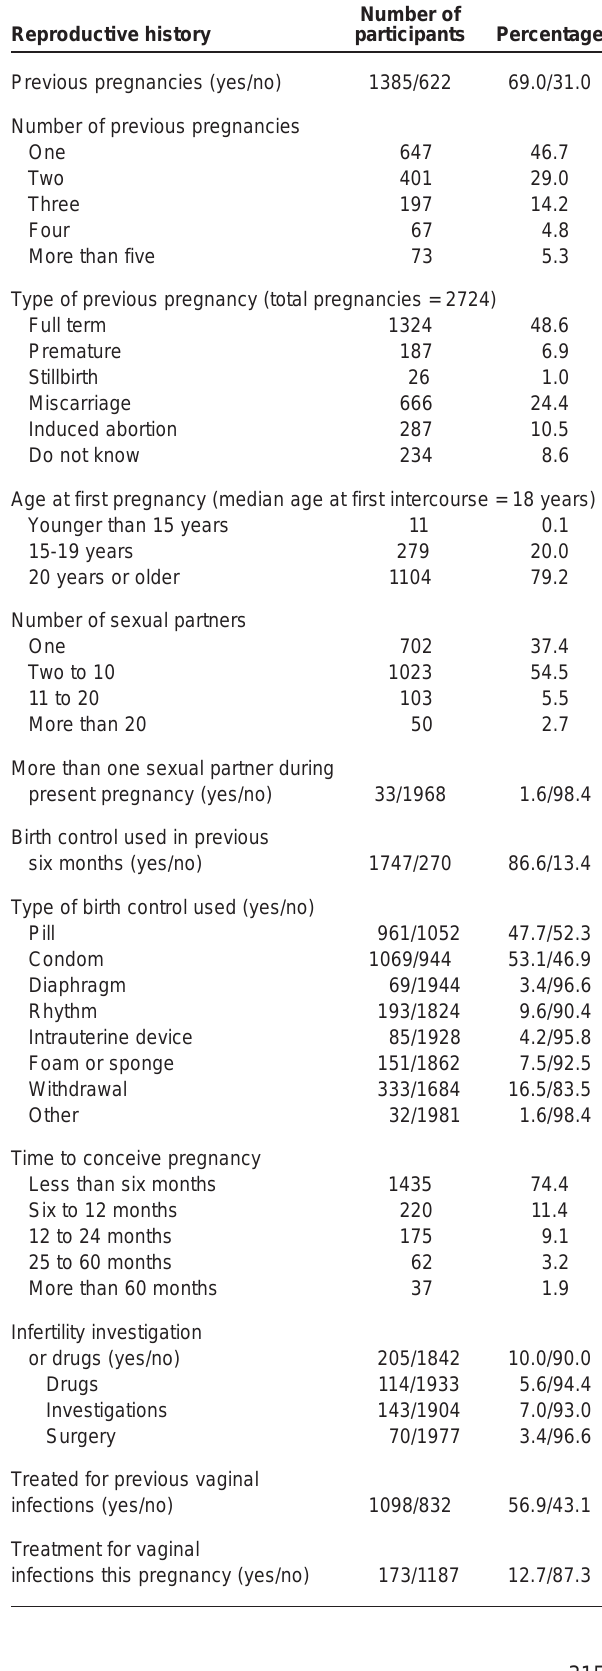
TABLE 4 Nutrition and exercise habits of participants in the Edmonton Perinatal